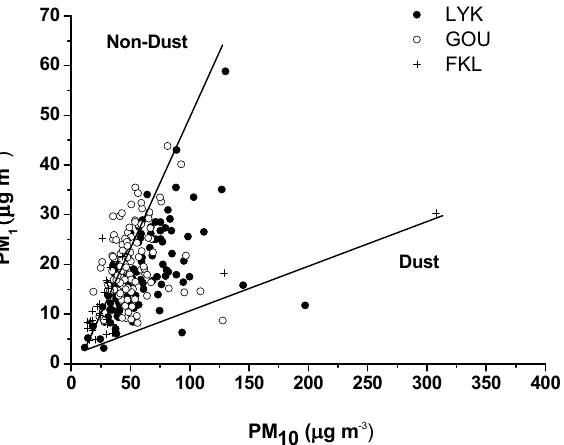
Fig. 5. PM 1 /PM 10 ratios for all three stations during dust and non- dust